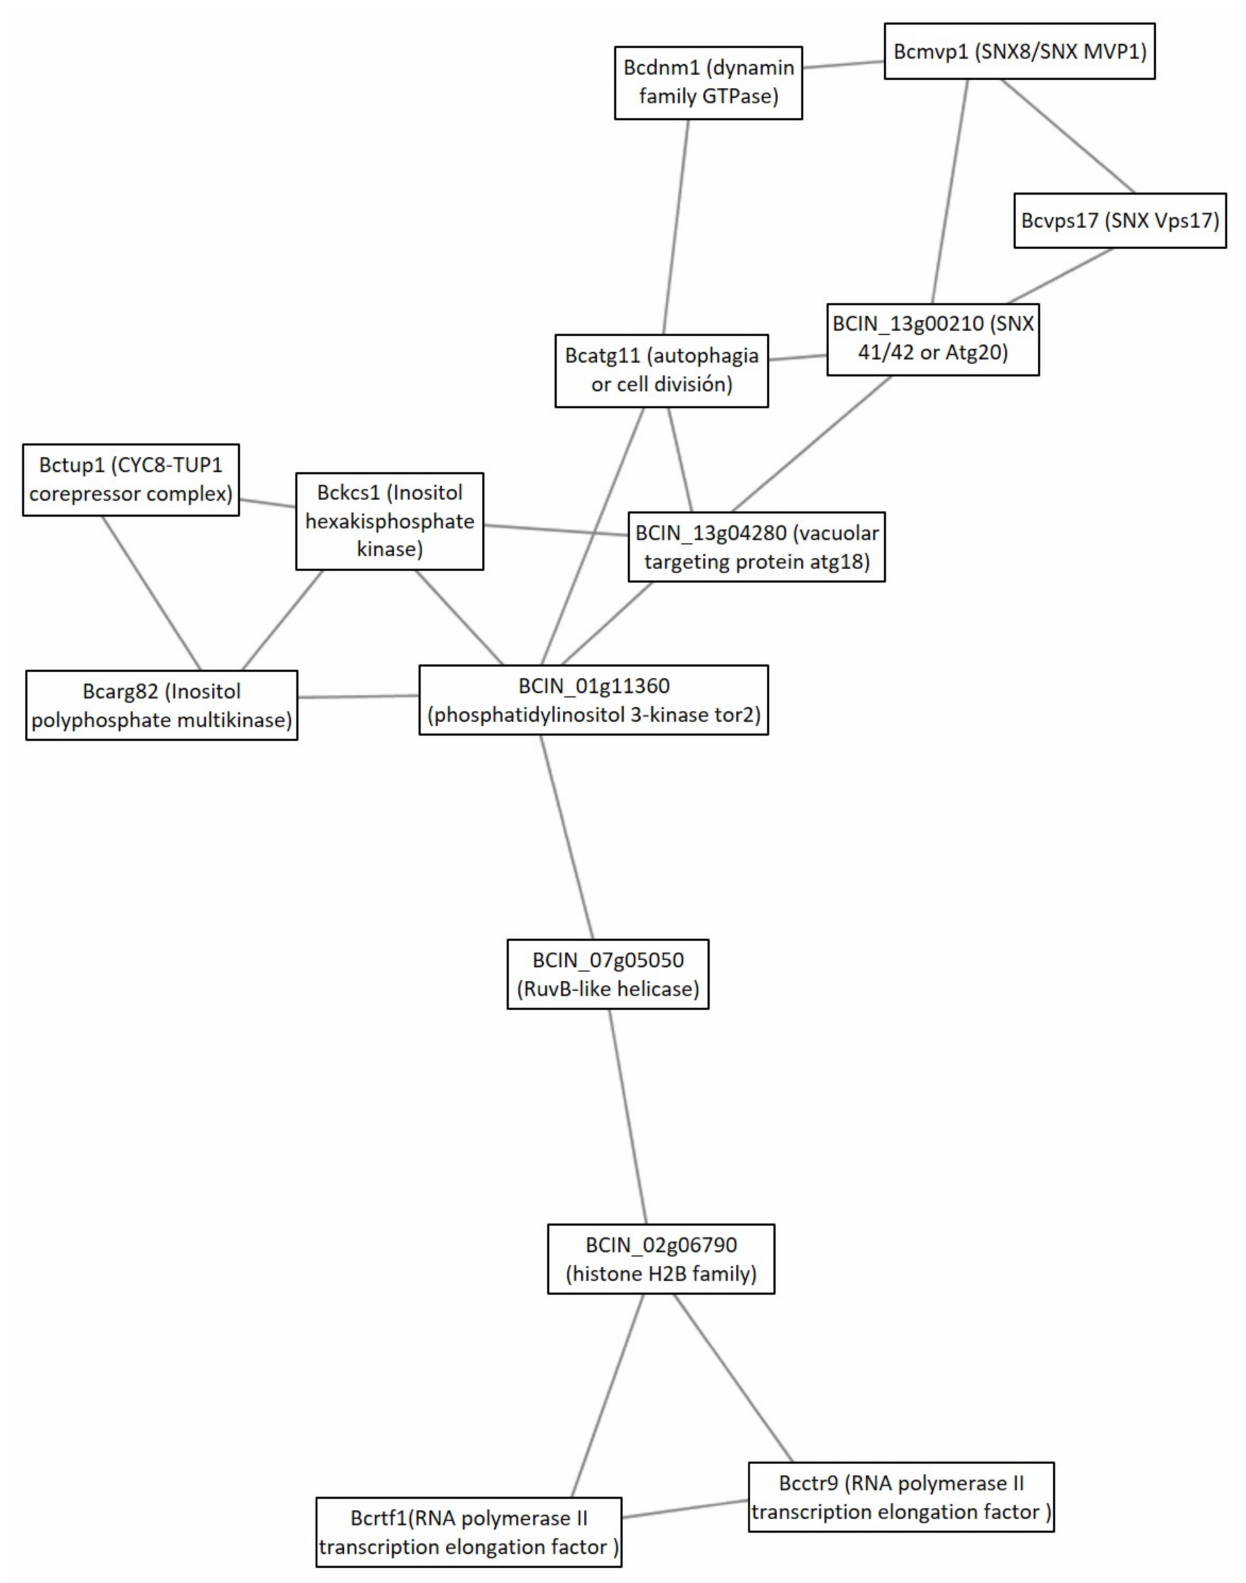
Figure 5. Cluster 24: signaling cluster under the GLU condition. Clusters were obtained analyzing STRING networks of protein, exclusively identified or overexpressed in B. cinerea proteomes (membranome, phosphoproteome, phosphomem- branome, and secretome) under GLU with